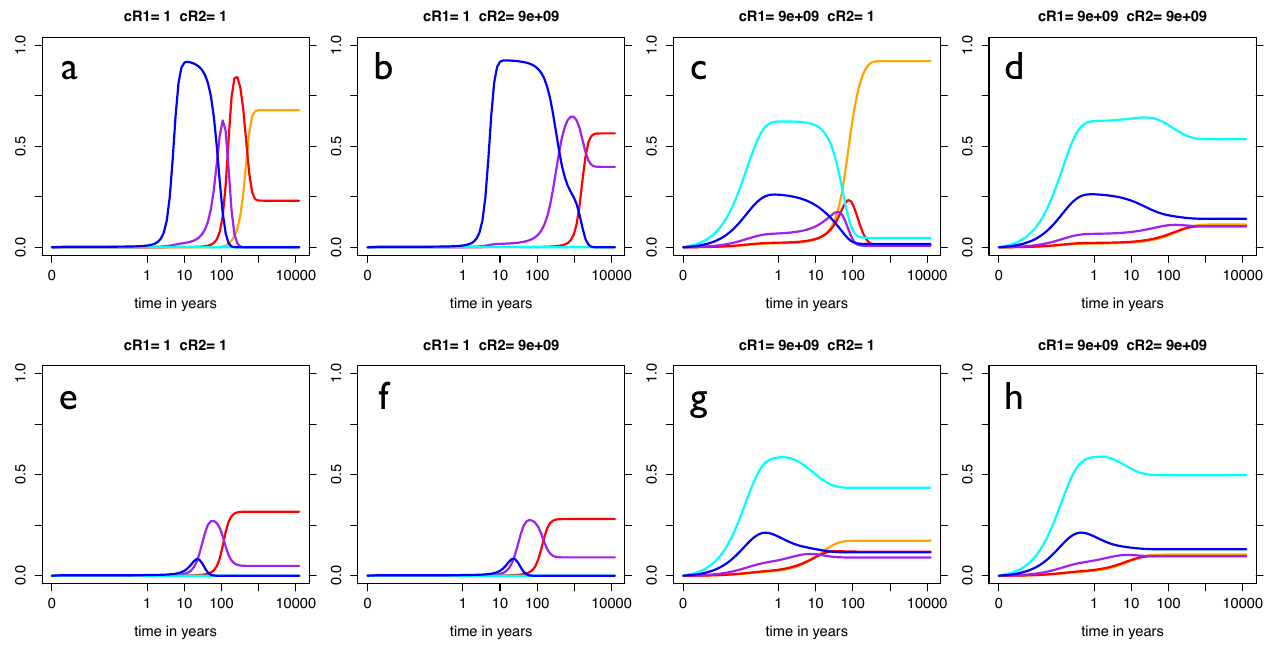
Fig. 7. Time-series of population dynamics for seed competition working ( c R1 = 1) or neutral ( c R1 = 9 e + 9), resource competition working ( c R2 = 1) or neutral ( c R2 = 9 e + 9) for c Mort = 0 . 05 (a–d) and c Mort = 1 (e–h) . Each colour represents the coverage of a PPS, corresponding to Fig.